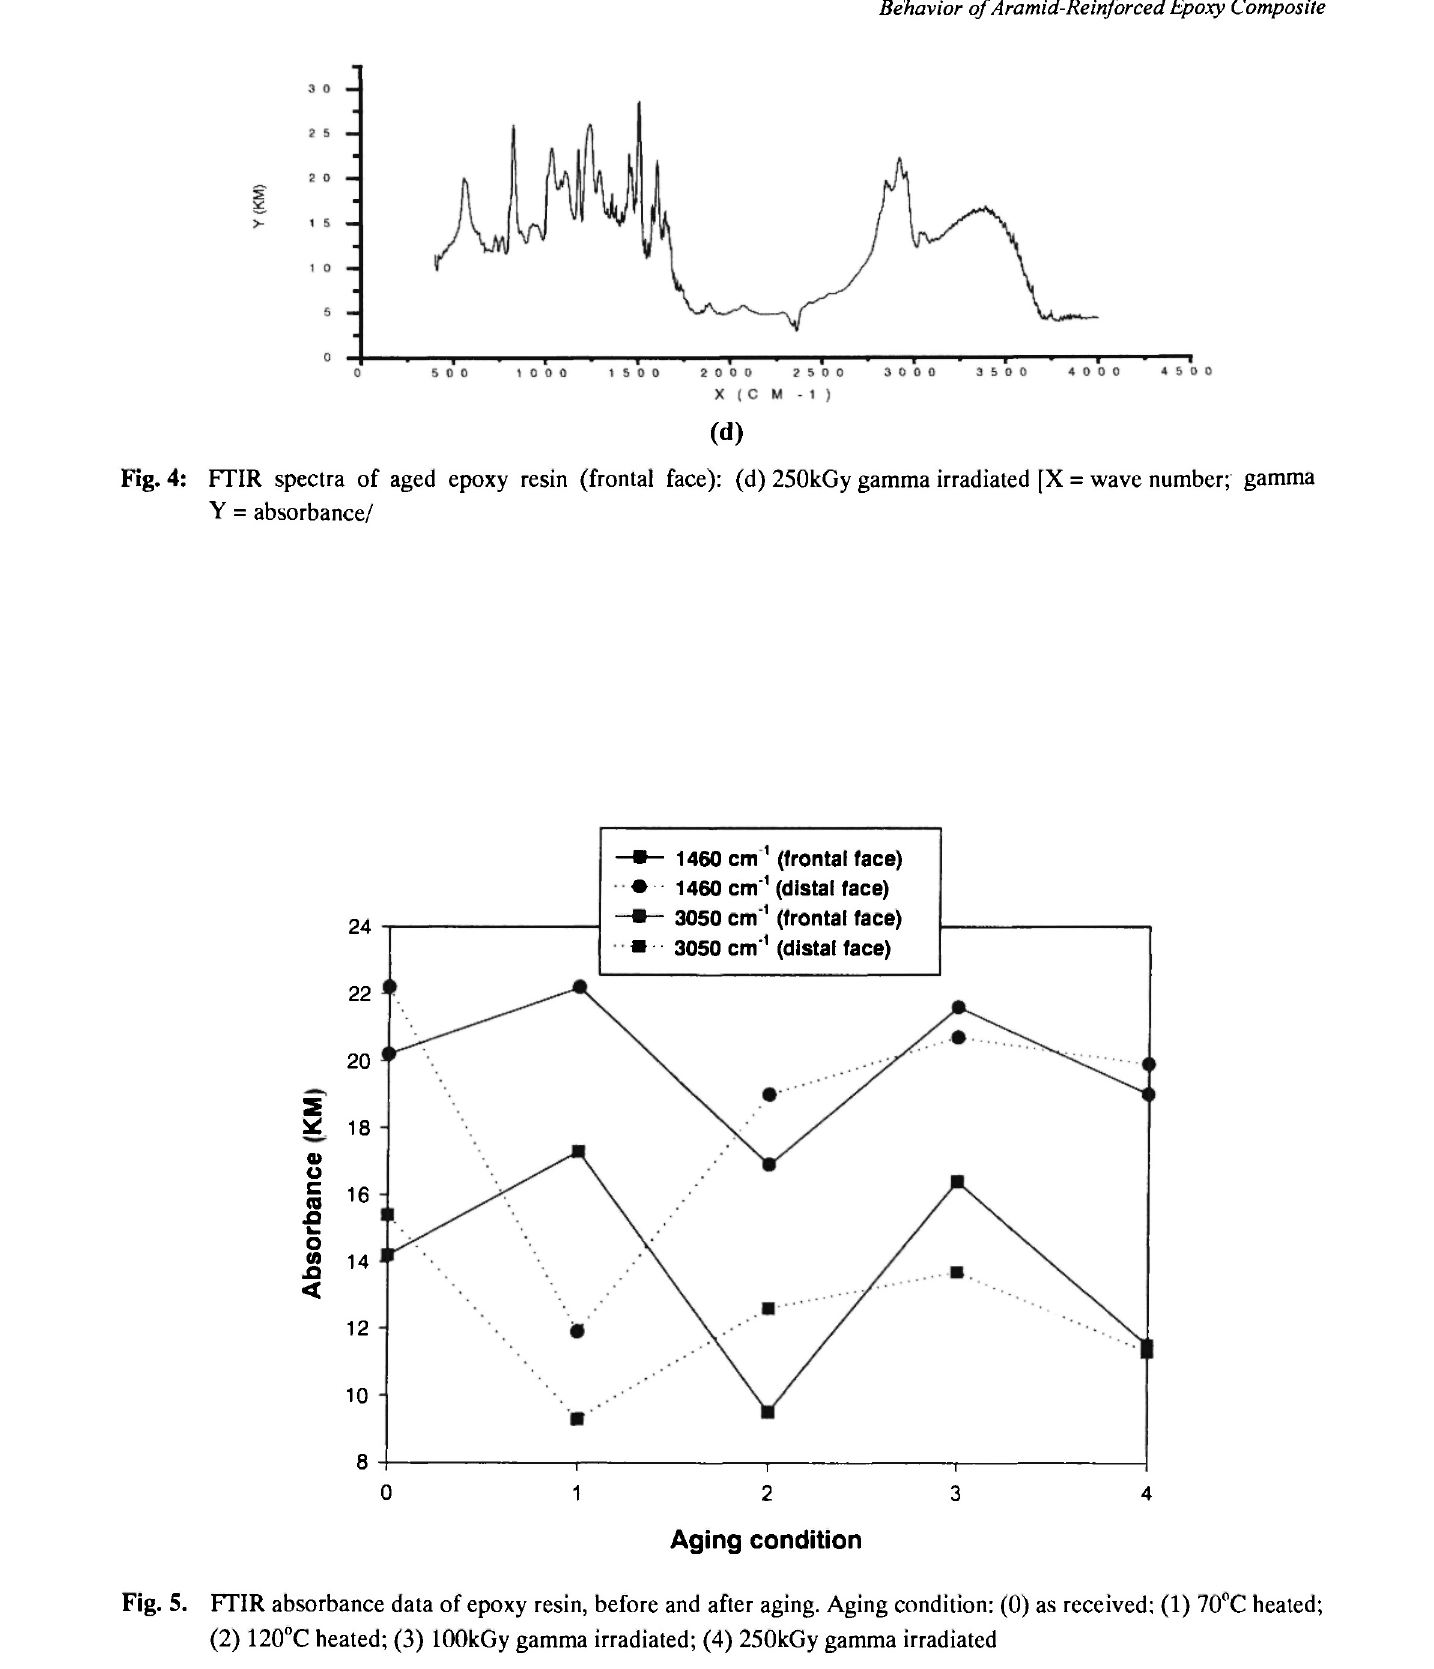
Fig. 5. FTIR absorbance data of epoxy resin, before and after aging. Aging condition: (0) as received; (1) 70°C heated; (2) 120°C heated; (3) lOOkGy gamma irradiated; (4) 250kGy gamma